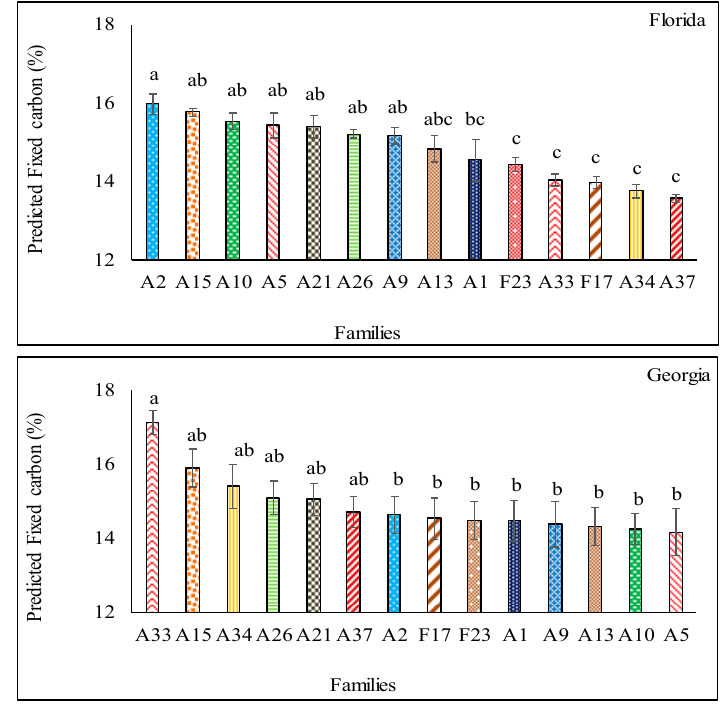
Figure 3. Rank of loblolly pine families for fixed carbon content. * Bars with different letters are significantly different at 95% confidence level (Tukey’s HSD Test).